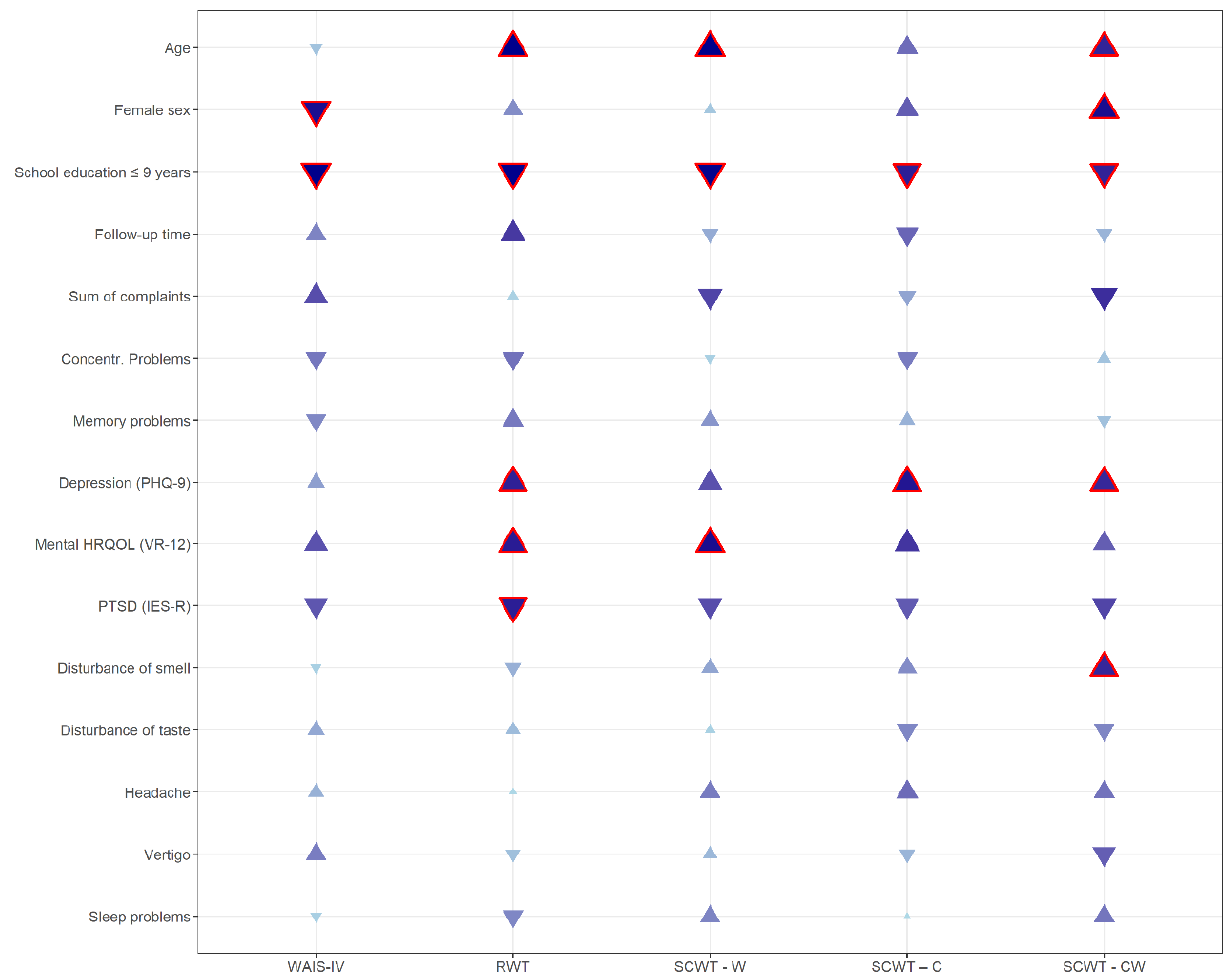
Figure 1. Multivariable linear regression models for the cognitive tests Wechsler Adult Intelligence Scale (WAIS-IV); Regensburger Wortflüssigkeitstest (verbal fluency) (RWT); and Stroop Color and Word Test (SCWT), word (W), color (C), color words (CW). Directions of triangles correspond to the directions of estimates. Triangles outlined in red represent significant p -values. The color and size of triangles are based on the p -values (i.e., large dark blue triangles represent low p -values and vice